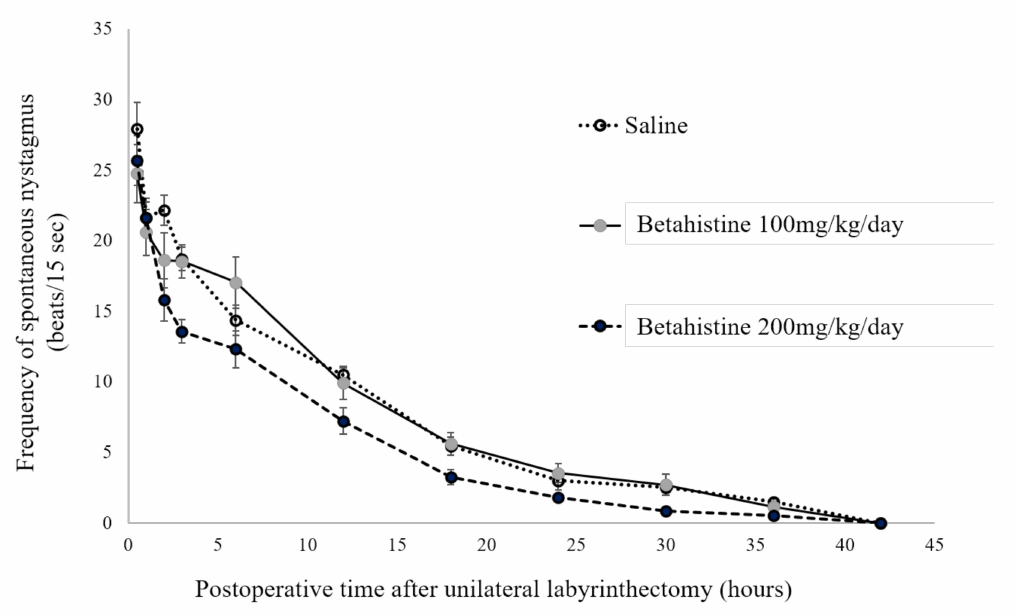
Figure 1. Effects of betahistine on changes with time in the frequency of spontaneous nystagmus after unilateral labyrinthec- tomy in rats. Each point represents the mean number of quick-phase eye movements in 15 s. Saline: rats received intraperitoneal infusion of saline, shown as open circles with a dotted line. Betahistine 100 mg/kg/day: rats received intraperitoneal infusion of betahistine at a dose of 100 mg/kg/day, shown as gray circles with a solid line. Betahistine 200 mg/kg/day: rats received intraperitoneal infusion of betahistine at a dose of 200 mg/kg/day, shown as filled circles with a broken